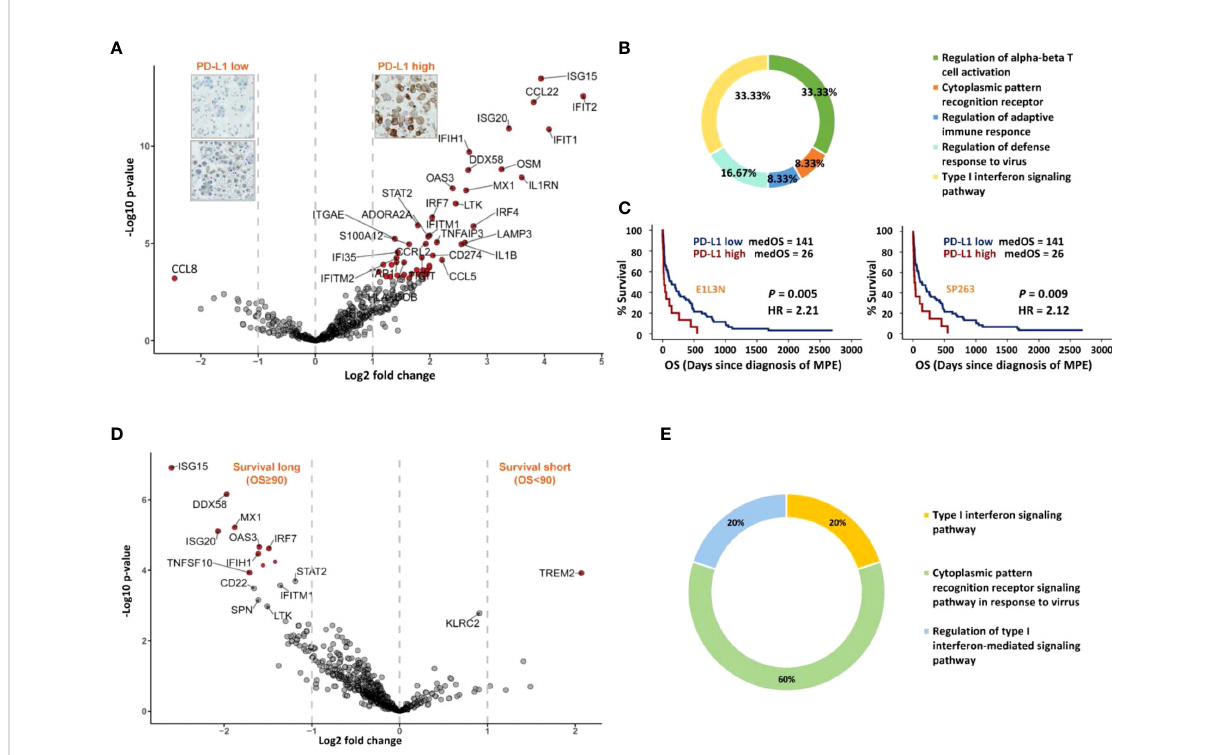
FIGURE 3 Immune gene expression analysis according to MPE LADC PD-L1 expression (tumour cells) and patient survival. (A) Differential 730 genes expression analysis. Genes with twice fold expression change and FDR less than 0.05 were marked in red. (B) Chart showing the most important cell biological pathways upregulated in the PD-L1 high group from Gene Ontology (GO) analysis. (C) Kaplan-Meier survival analysis for patients with PD-L1 high versus low expressing tumours, using clones E1L3N and SP263. The P-value (P) of the log-rank test is indicated. (D) Differential gene expression (730 genes) analysis of patients with long and short-survival (cut-off = median OS, 90 days), respectively. Genes with 2 times fold expression change and FDR < 0.05 were marked in red. (E) Chart showing the most signi fi cant terms in the long-survival group (GO analysis). Only terms with corrected p-value < 0.05 were